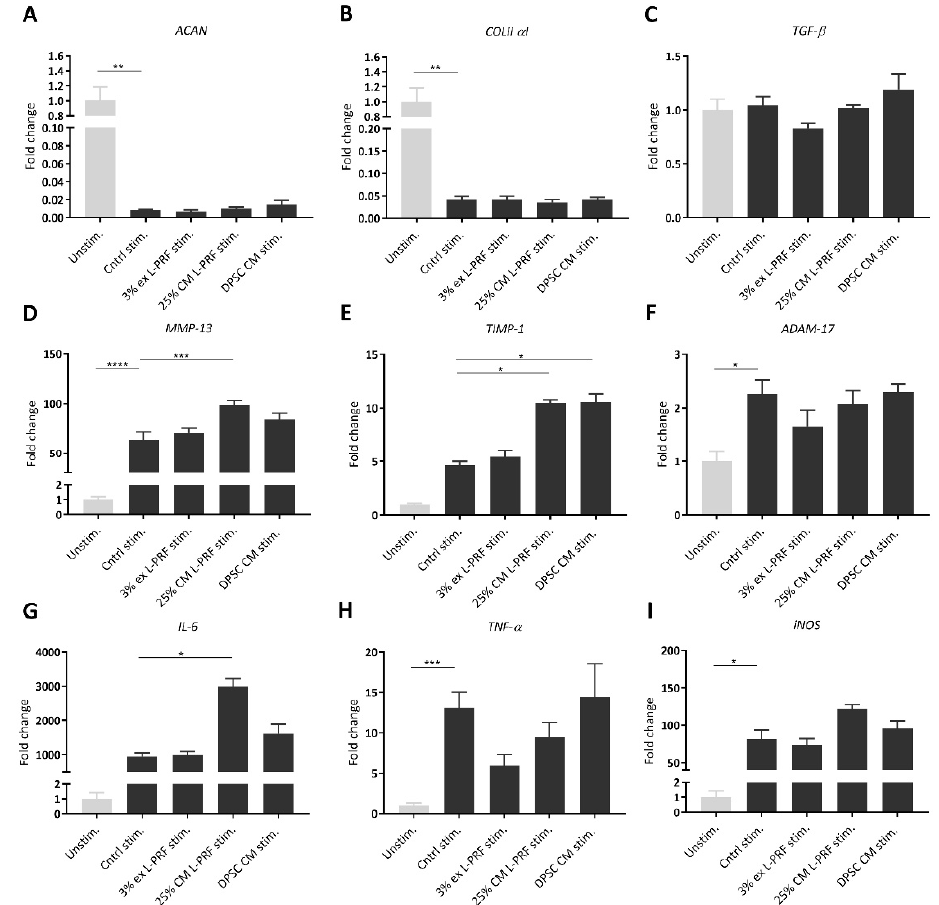
Figure 3. E ff ect of L-PRF ex, L-PRF CM and DPSC CM on TNF- α - and IL-1 β - stimulated iMAC OA-related gene expression. Relative mRNA levels were determined by RT-qPCR of unstimulated and cytokine-stimulated iMACs exposed to 3% L-PRF ex, 25% L-PRF CM and DPSC CM. ( A , B ) Chondrocyte marker genes, aggrecan and collagen type II α 1 , were significantly downregulated by cytokine stimulation, but not significantly altered by L-PRF ex, L-PRF CM and DPSC CM. ( C ) TGF- β mRNA levels were not altered upon exposure to cytokines, nor in combination with L-PRF ex, L-PRF CM or DPSC CM. ( D ) MMP-13 was significantly upregulated after cytokine stimulation, while 25% L-PRF CM further increased MMP-13 mRNA levels compared to the stimulated control. ( E ) TIMP-1 was upregulated by the supplementation of pro-inflammatory cytokines combined with 25% L-PRF CM and DPSC CM. ( F ) ADAM-17 expression was significantly upregulated after cytokine stimulation but not altered after exposure to L-PRF ex, L-PRF CM and DPSC CM. ( G ) 25% L-PRF CM significantly augmented the IL-6 mRNA levels compared to the stimulated control. ( H , I ) TNF- α and iNOS mRNA levels were upregulated upon exposure to cytokines, but not altered by the supplementation of L-PRF ex, L-PRF CM or DPSC CM. Data correspond to n = 6 for L-PRF ex and L-PRF CM and n = 7 for DPSC CM. Data are represented as mean ± S.E.M. * p ≤ 0.05. ** p ≤ 0.01. *** p ≤ 0.001. **** p ≤ 0.0001.